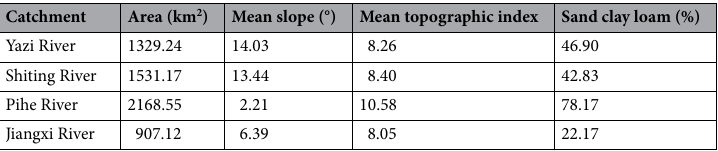
Table 1. Topographic characteristics of the four sub-catchments within Tuojiang River catchment.